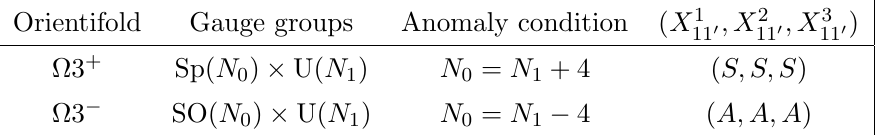
Table 3. The unoriented projection (cid:10)3 (cid:6) (on the singular space) of the orbifold model C 3 = Z 3 which, in the resolved space, is a compact (cid:10)7-plane. The (cid:12)elds X I or antisymmetric representation, where \A" stands for \Antisymmetric representation", while \S" for \Symmetric